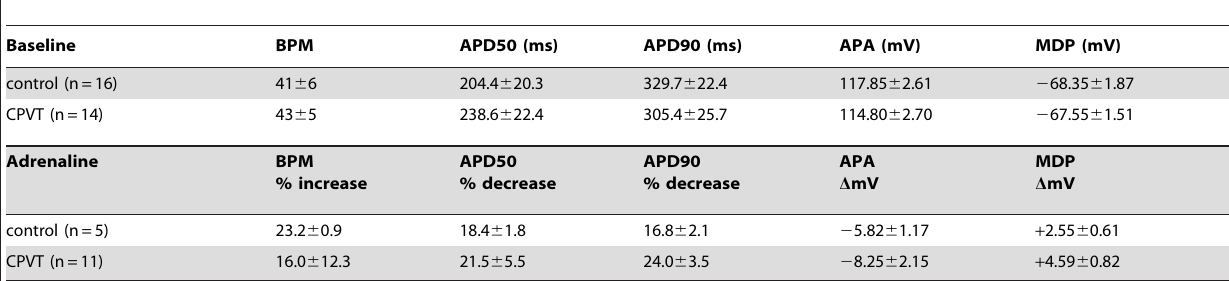
Table 2. Characteristics of spontaneous ventricular-like APs in control and CVPT-CMs during regular beating.